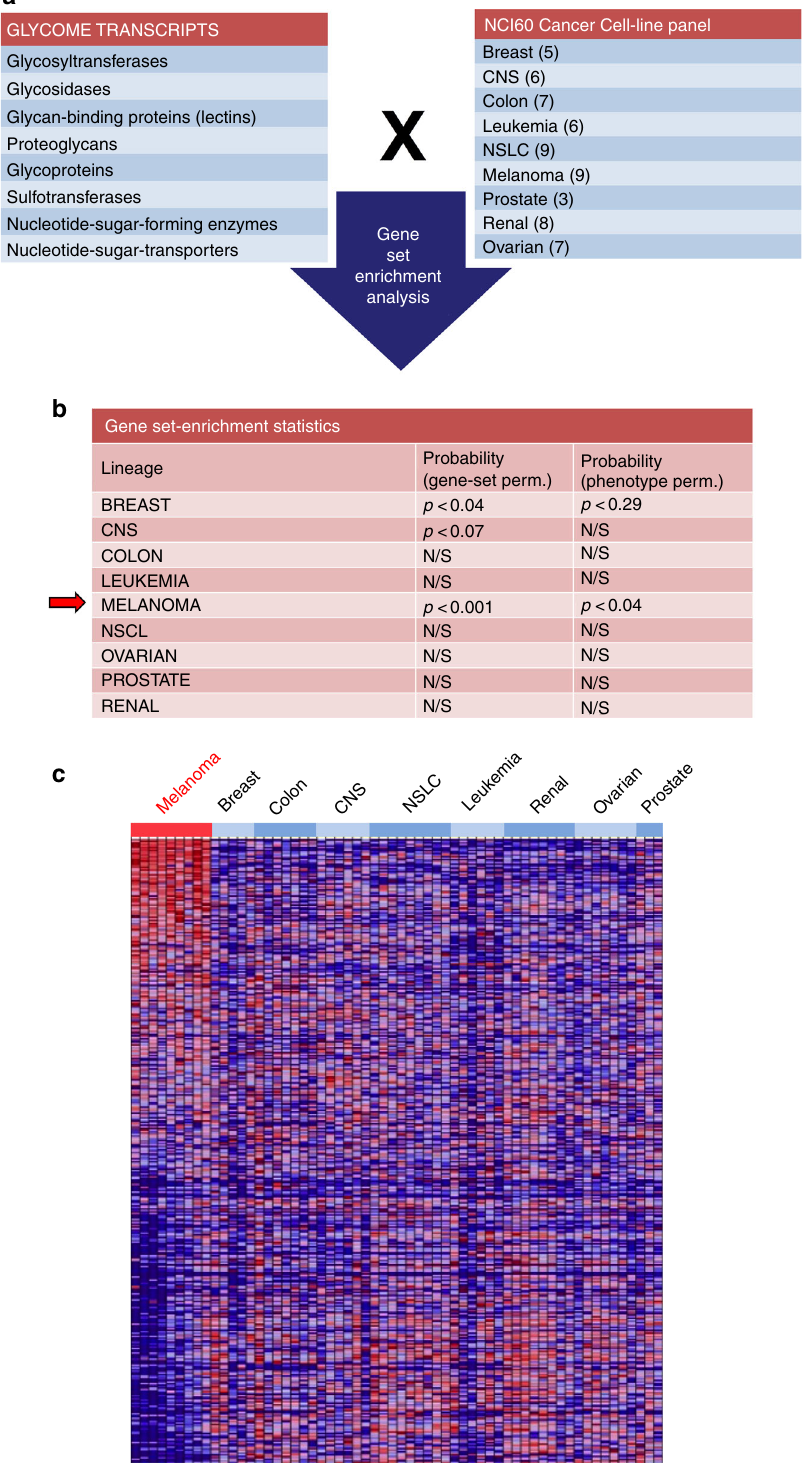
Fig. 1 Human melanomas are enriched for changes in glycosylation-related genes. a Glycome gene transcripts ( n = 698) selected for gene set enrichment analysis (GSEA) among the NCI-60 cancer cell line panel. b Gene- and phenotype-based permutation statistical analysis of GSEA results among the NCI- 60 cancer cell line panel. c Heat map of glycome gene relative expression (red — increased; blue — decreased) in melanoma cell lines compared with all other cancer cell